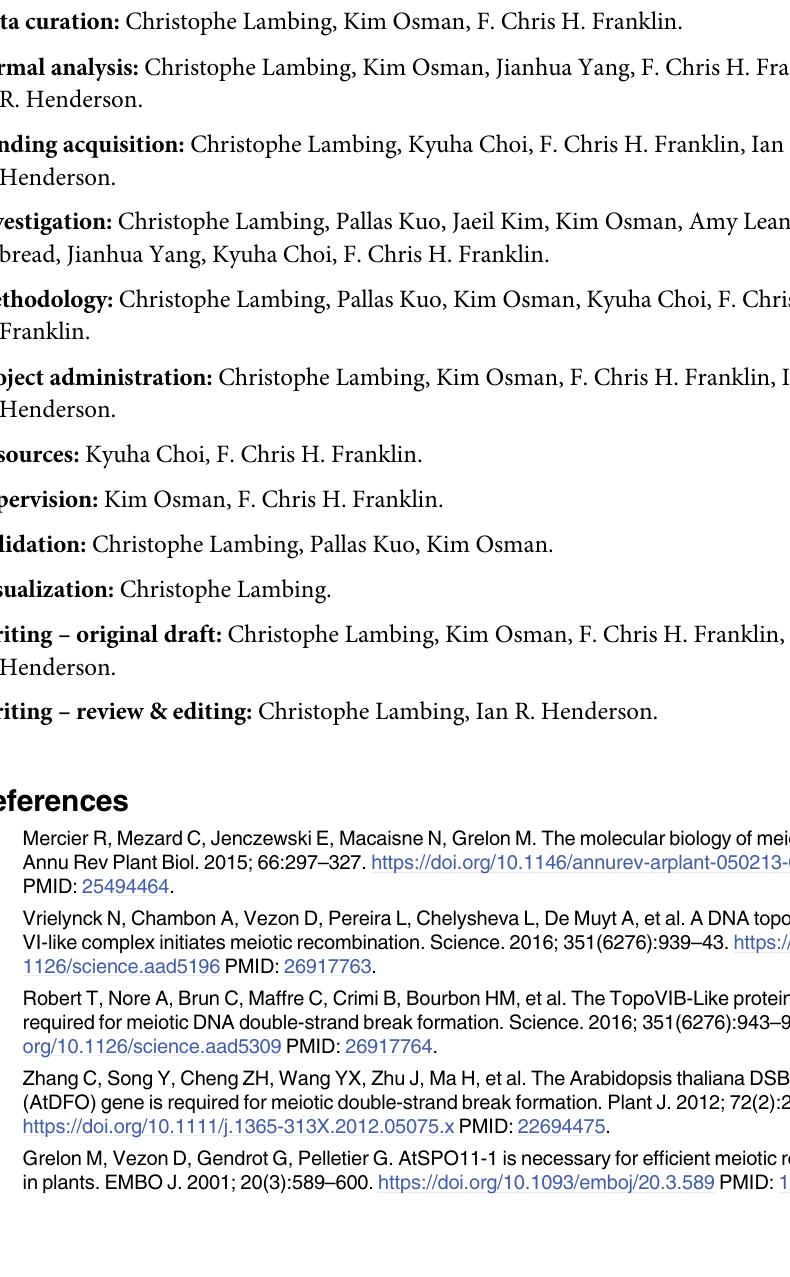
S12 Table. Primers used to clone ASY1 , ASY3 , PRD3 and PCH2 into protoplast transient expression